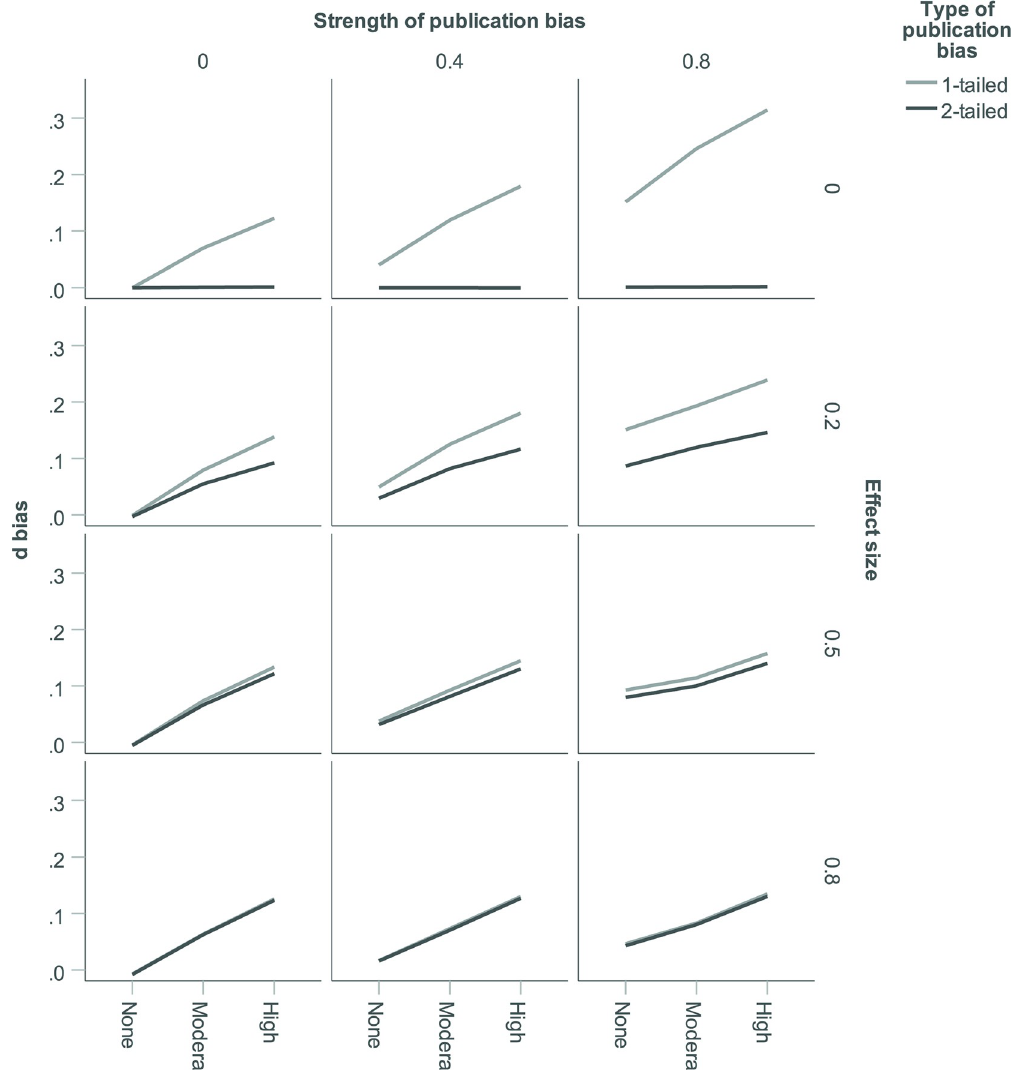
Fig 8. Bias in effect size estimates ( d bias ) as a function of p -hacking environment, strength of publication bias, true average effect size ( θ ), and type of publication bias. Data shown are for the DL estimator but are very similar for other